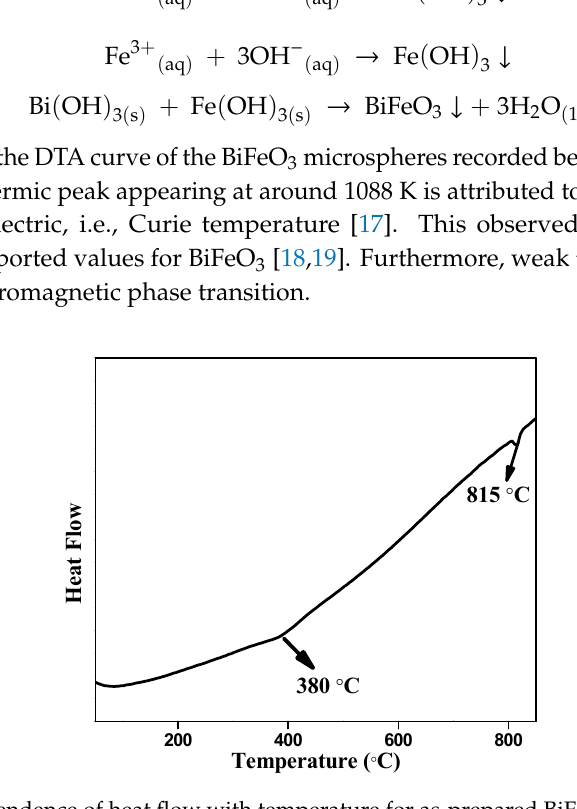
Figure 2. Dependence of heat flow with temperature for as-prepared BiFeO 3 microspheres.